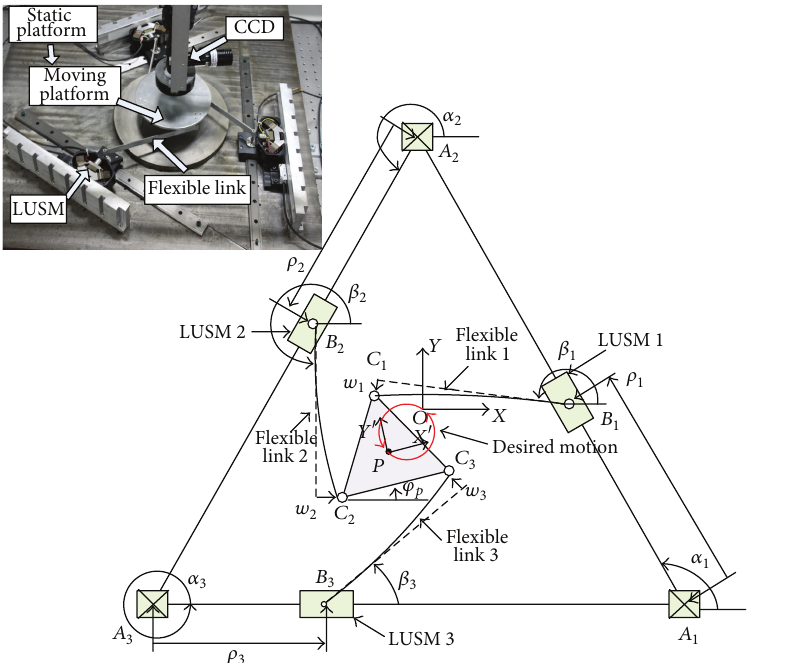
Figure 1: Prototype and schematic model of the PPM.